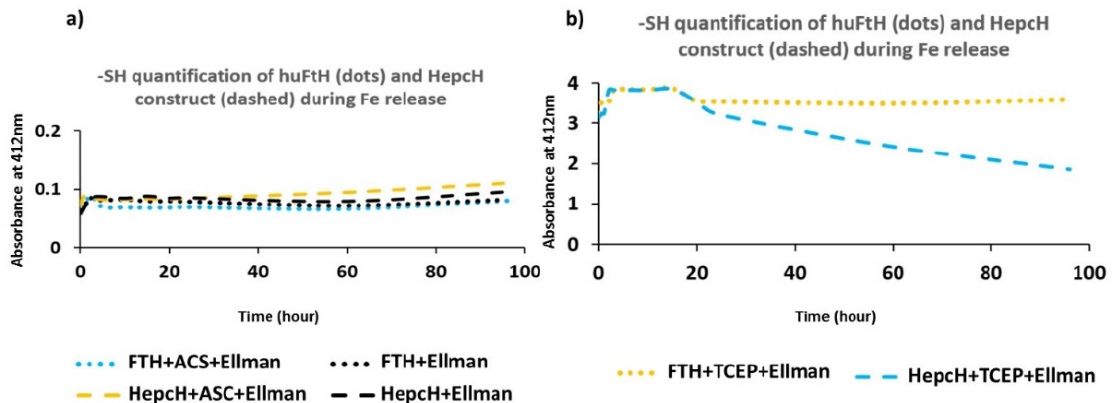
Figure 2. Time course of Ellman’s assay of FTH and HepcH during iron release. ( a ) Time course of Ellman’s assay of FTH and HepcH in presence of ascorbic acid reductant showing the absence of absorption bands at 412 nm. Turquoise dots: FTH reduced with ascorbic acid (FTH + ASC + Ellman). Black dots: non-reduced FTH (FTH + Ellman, control). Yellow dashes: HepcH reduced with ascorbic acid (hepcH + ASC + Ellman). Black dashes: non-reduced HepcH (hepcH + Ellman, control). ( b ) Time course of Ellman’s assay of FTH and HepcH in presence of TCEP reductant showing the presence of absorption bands at 412 nm. Yellow dots: FTH reduced with TCEP (FTH + TCEP + Ellman). Turquoise dashes: HepcH reduced with TCEP (hepcH + TCEP + Ellman). FTH and HepcH subunits reduced in presence of TCEP showed the presence of absorption bands at 412 nm with a pic after 18 h of incubation. Results are presented as the mean of two independent experiments.